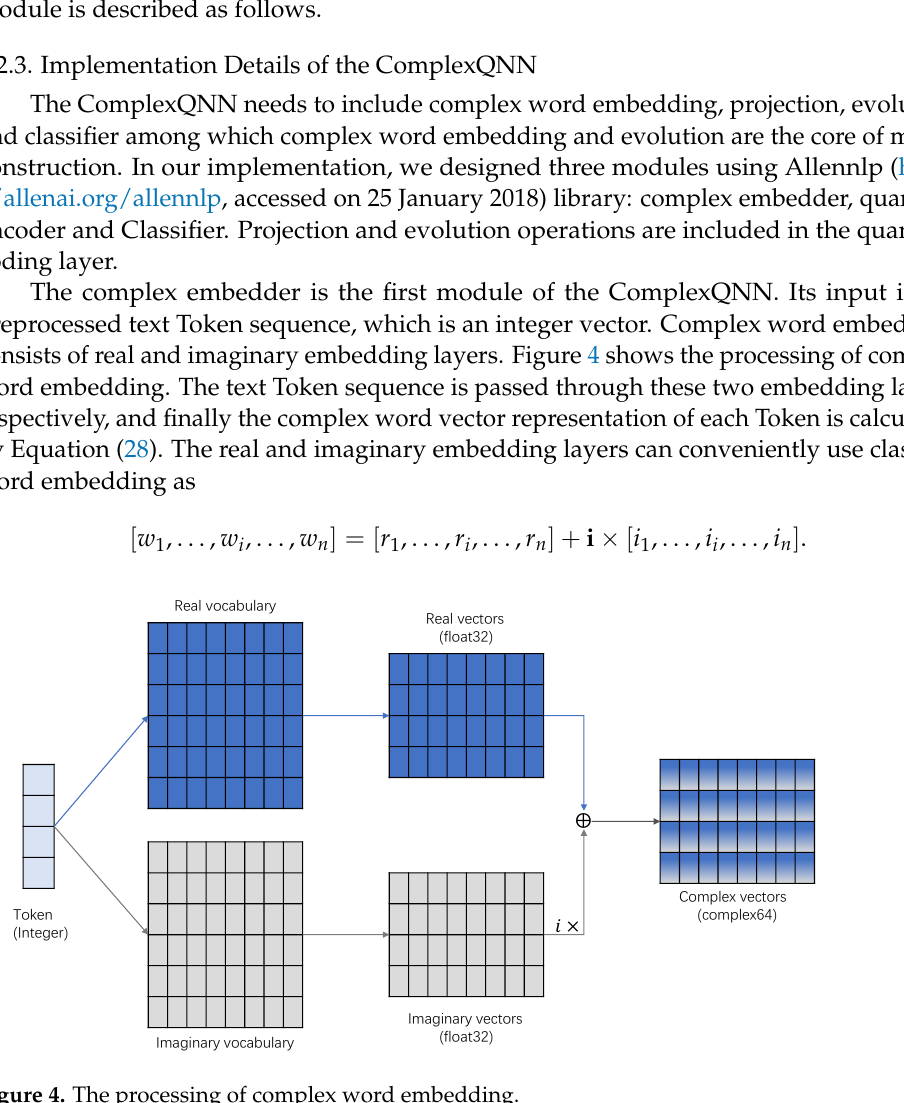
Figure 4. The processing of complex word